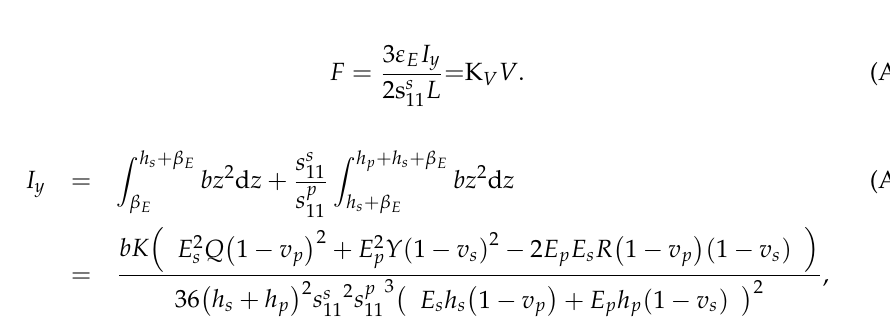
Figure A1. Deflection of the piezoelectric